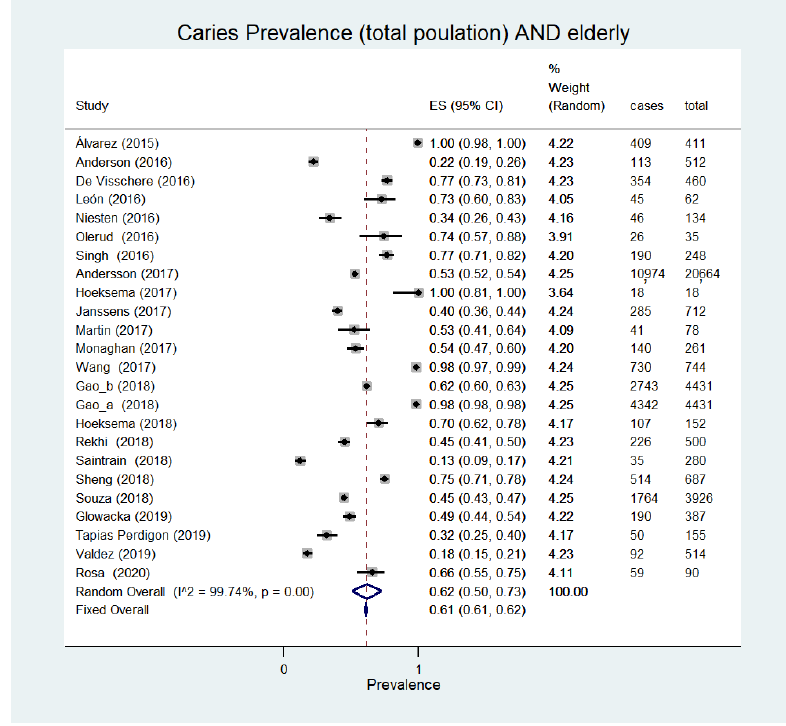
Figure 2. Caries prevalence (total population) AND elderly.